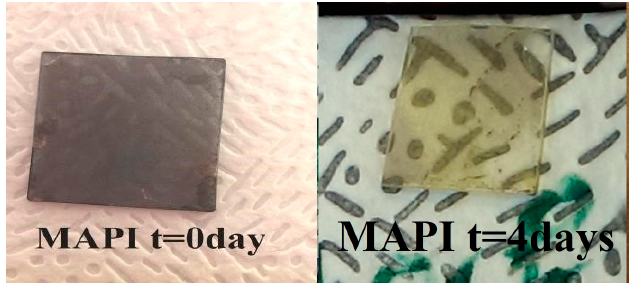
Figure 1. Photography of a 800 nm thick CH 3 NH 3 PbI 3 layer deposited by spin-coating on a quartz substrate, just after the deposition (t = 0 day) and 4 days after the deposition (t = 4 days).